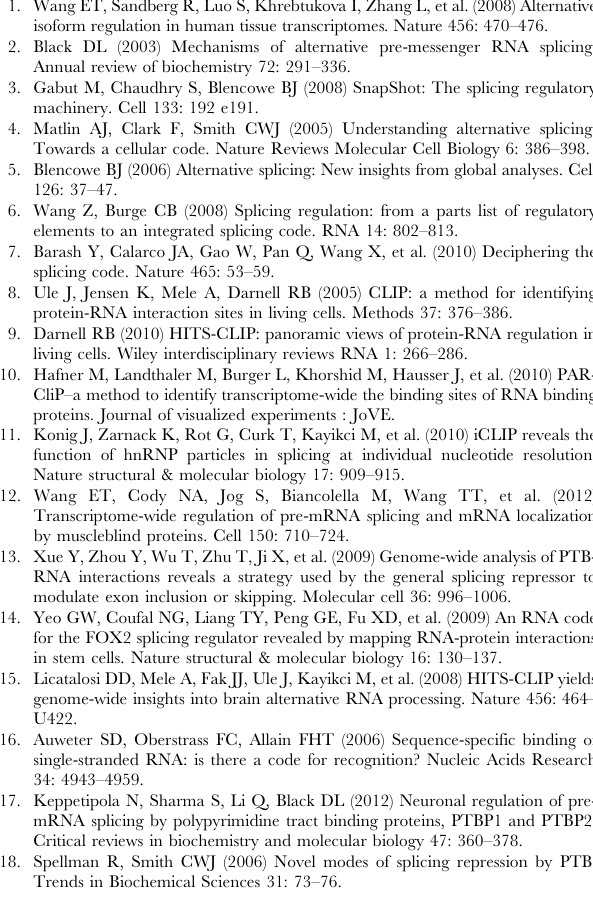
Table S1 Trained PTBP1 splicing regulation model. The table presents a summary of the multinomial logistic regression model for PTBP1 splicing regulation, including estimated coefficients and their statistics. Table S2 Enriched gene ontology categories for novel PTBP1-repressed exons. The table lists ontology entries enriched in genes with predicted PTBP1-repressed exons (prob- ability score of exon repression . 0.65). Whole mouse internal exons were used as the control set, and p-value cut off was 0.05. Gene ontology analysis was performed using the GOTM web